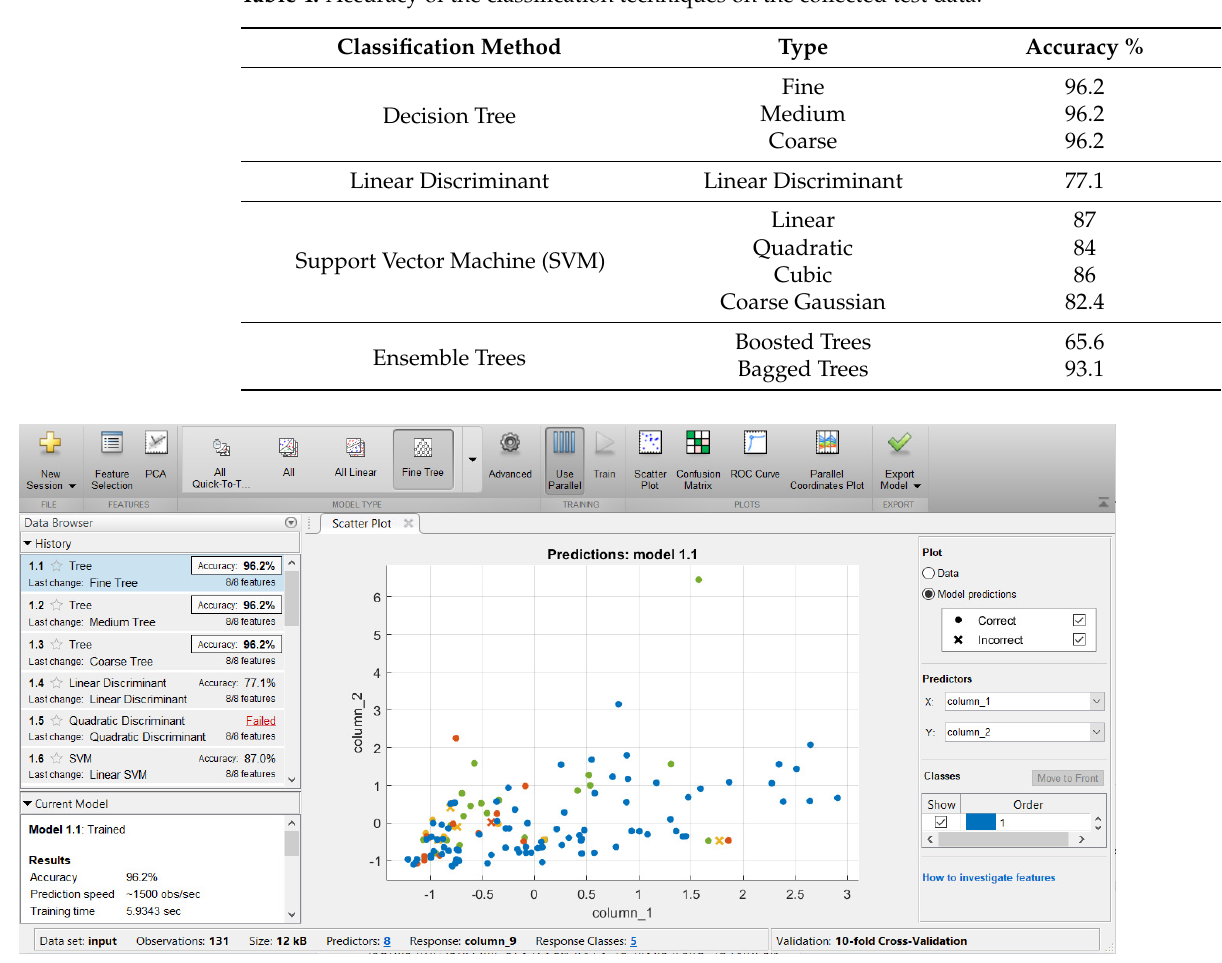
Table 4. Accuracy of the classification techniques on the collected test data.